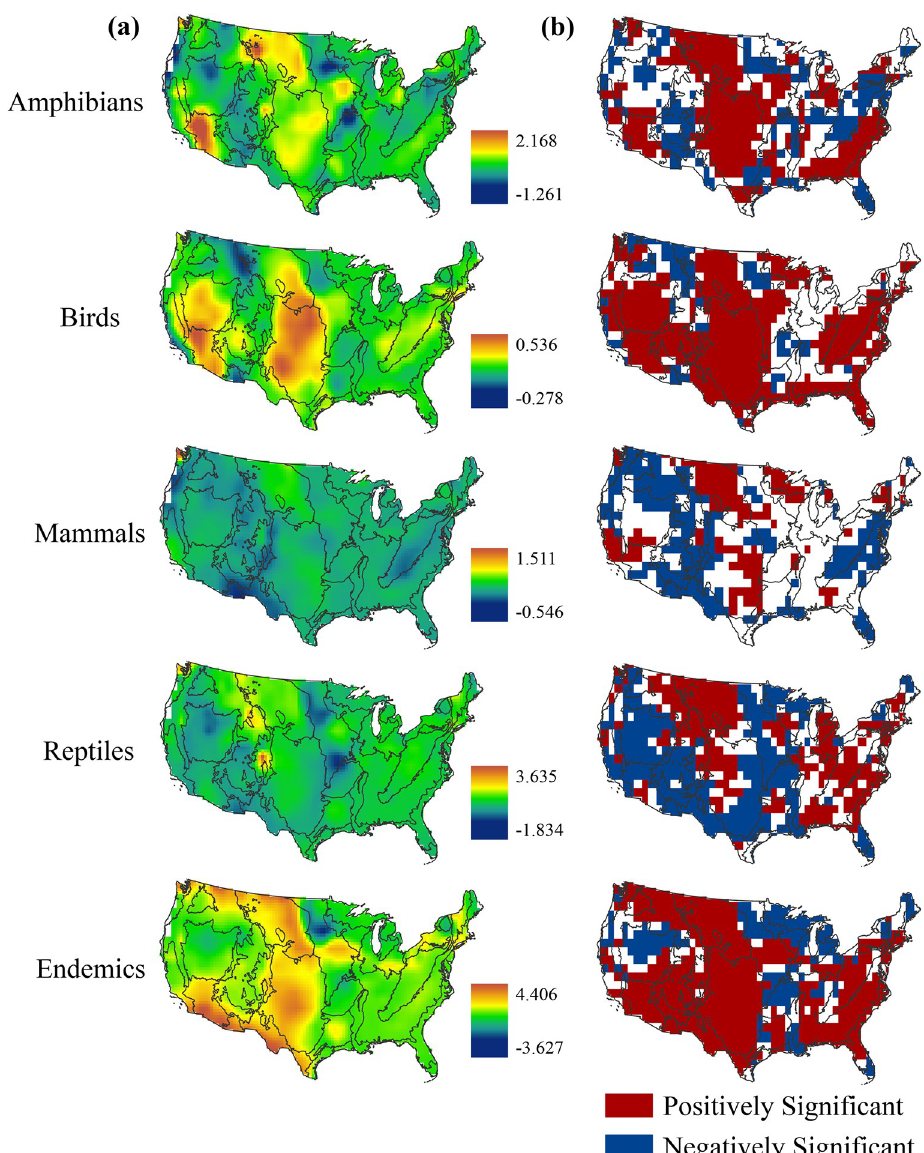
Fig 3. Spatially varying coefficient estimates of wetland coverage from Bayesian spatial Poisson models. ( a ) Spatially varying coefficients of wetland cover for the five taxonomic groups varied across the conterminous U.S. ( b ) Spatial variations in species richness and proportional wetland coverage were positively (red) and negatively (blue) significant at the 95% credible level in different ecological regions of the study area. Areas in white are not statistically significant. All maps are presented with the level II ecoregions of the conterminous